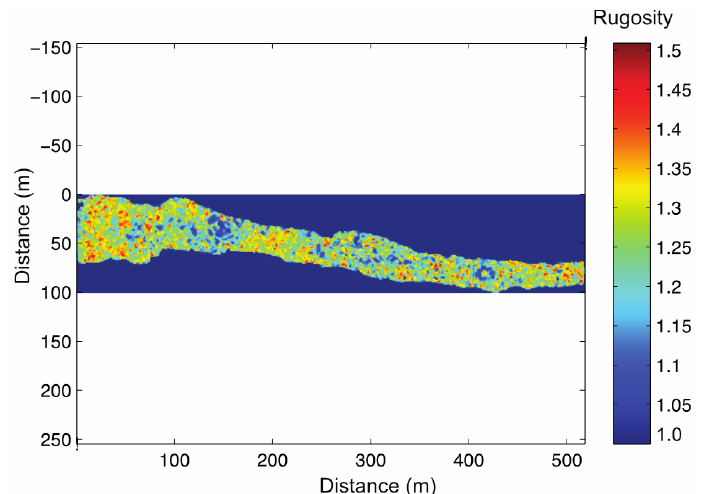
Figure 7. Heat-map of surface rugosity of a section of a 500 m of the reef transect. Both x and y -axes denote distance in metres, the transect width ranged from 4 to 30 m. Surface rugosity was calculated in 2 × 2 m quadrats. Structural complexity was calculated as in [30], where a value of 1 represents a flat quadrat and the index increases with habitat structural complexity.